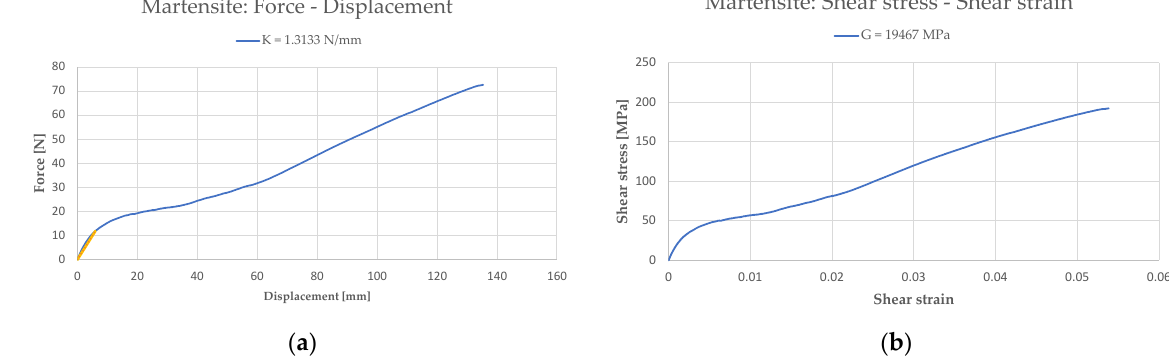
Figure 12. Mechanical and material properties of the martensite state: ( a ) force–displacement; ( b ) shear stress–shear strain.